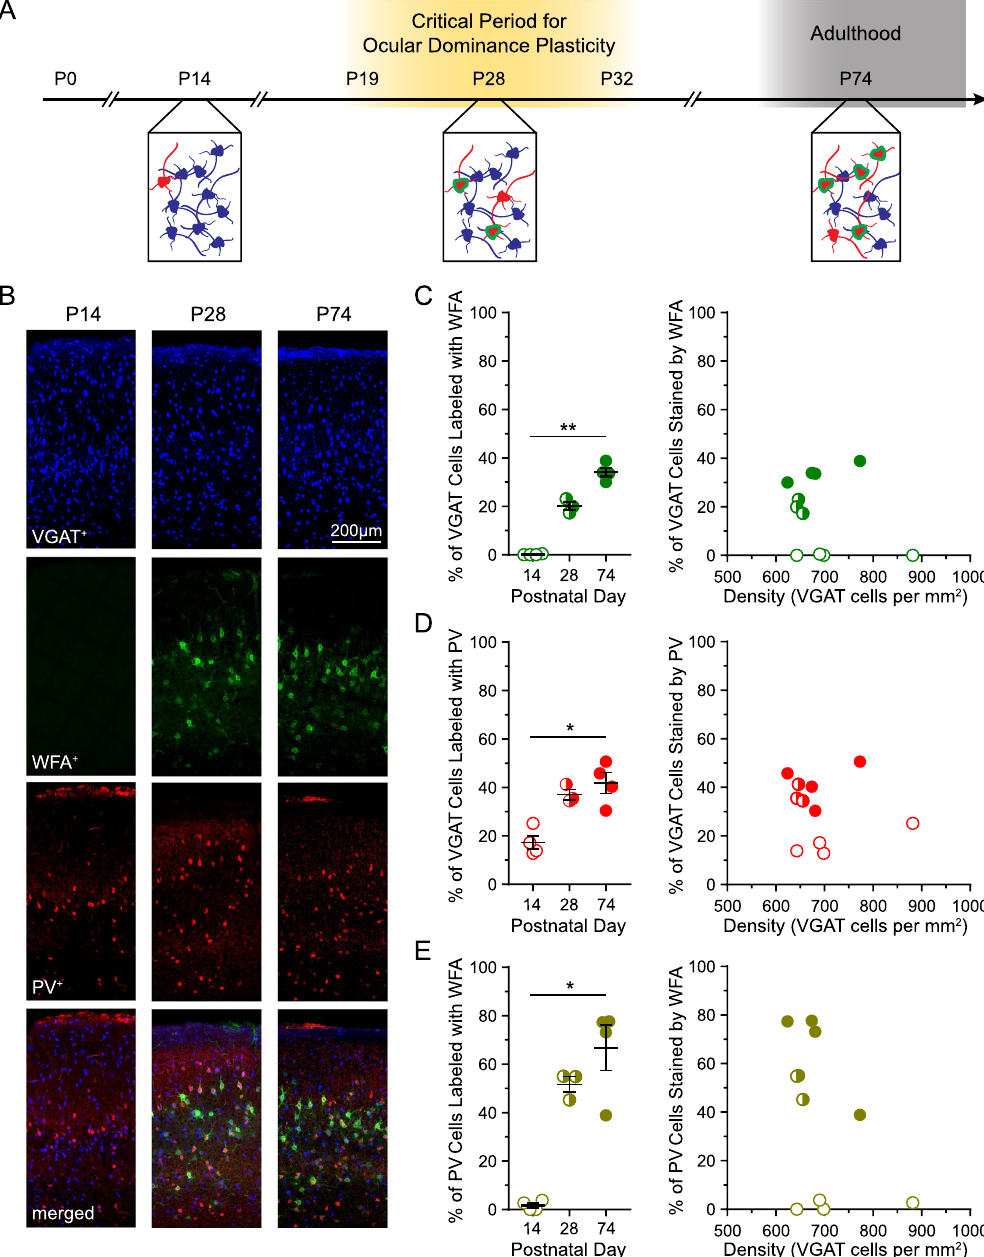
Figure 1. Deposition of PNNs onto PV inhibitory neurons in developing visual cortex. ( A ) Schematic timeline of PNN (green) development onto developing PV inhibitory neurons (red). At postnatal day 14 (P14), PNNs are absent and few inhibitory neurons (blue) express PV. By P28, at the height of the critical period, PNNs appear on some PV neurons. By P74, in adulthood, the density of PNNs has reached a mature level and most inhibitory PV cells carry PNNs. ( B) Example sections from P14, P28, and P74 mice expressing a fluorescent protein in all VGAT neurons (blue). Wisteria Floribunda Agglutinin (green) lectin staining reveals the presence of PNNs. Nearly all PV cells (red) are co-localized with VGAT. ( C ) The percentage (left) of VGAT neurons co-labeled with WFA increases across postnatal age (P14 = 0.14 ± 0.12 (open), P28 = 20.11 ± 1.66 (half filled), P74 = 34.1 ± 1.82 (filled)) but is not correlated with VGAT cell density (right). ( D ) The percentage (left) of VGAT neurons expressing PV increases during postnatal development (P14 = 17.28 ± 2.79 (open), P28 = 37.09 ± 2.14 (half-filled), P74 = 41.79 ± 4.34 (filled)) but is not correlated with VGAT cell density (right). ( E ) percentage (left) of PV neurons stained with WFA increases across postnatal development (P14 = 1.63 ± 0.96 (open), P28 = 51.69 ± 3.24 (half-filled), P74 = 66.75 ± 9.34 (filled)). n P14 = 6,391 VGAT cells, 10 sections, 4 mice; n P28 = 7,159 cells, 11 sections, 3 mice; n P63 = 6,064 cells, 9 sections, 4 mice. Error bars represent